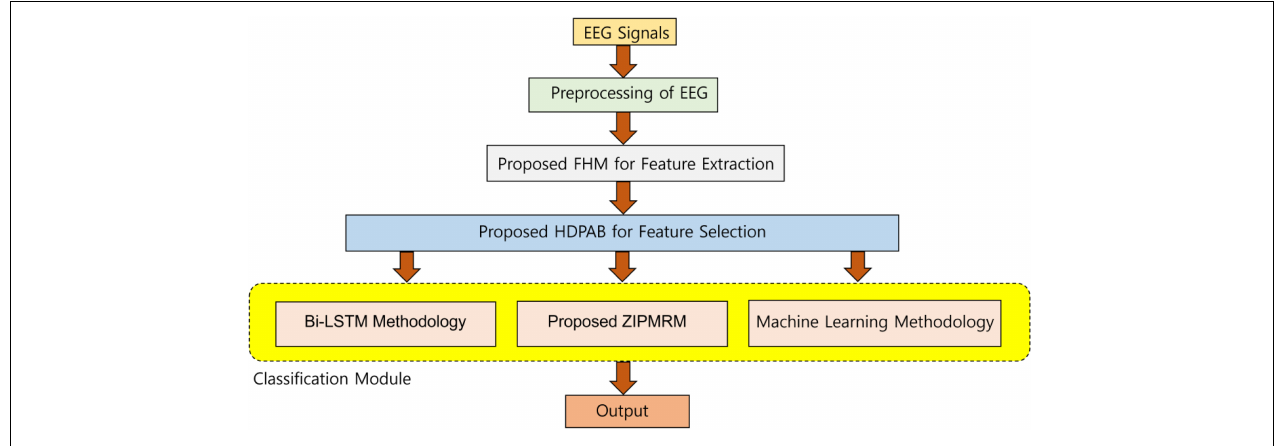
FIGURE 1 | A very simplified workflow of the representation for an easy understanding.